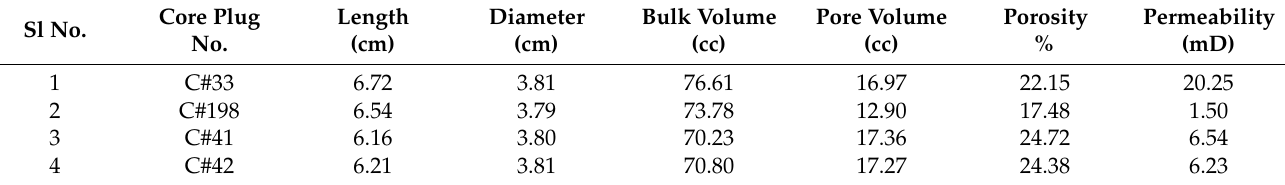
Table 3. Properties of the core plugs used for coreflooding